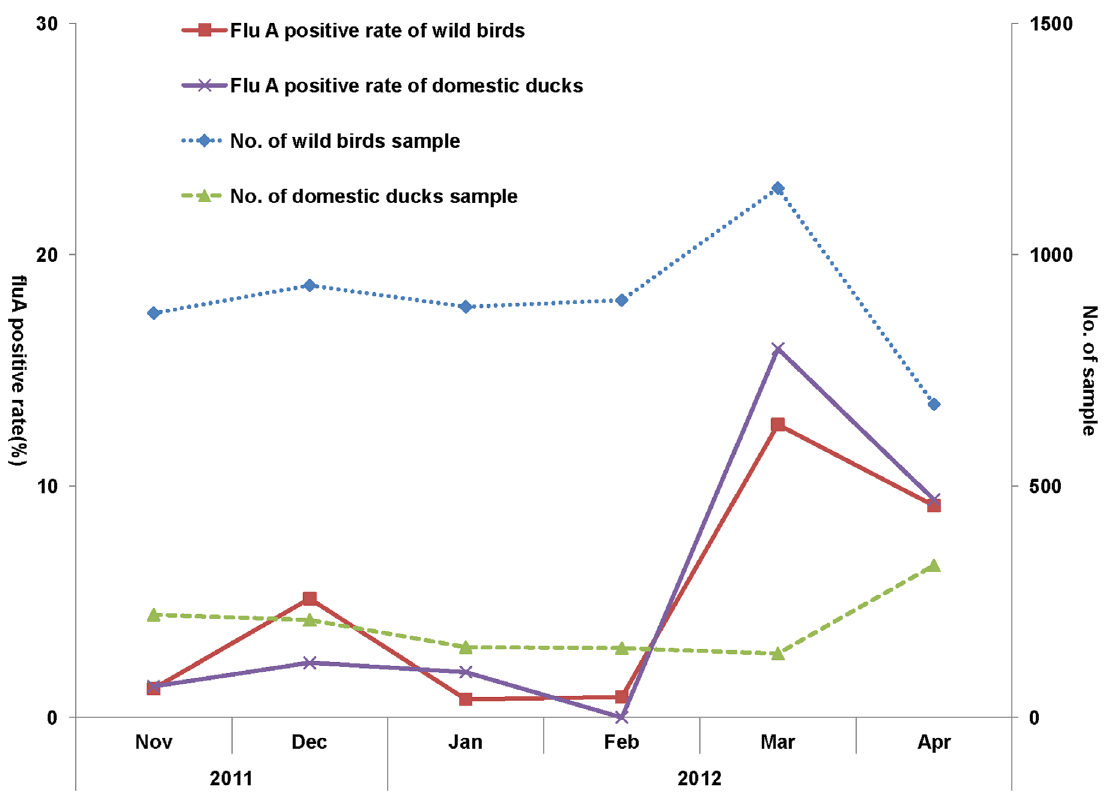
Figure 2. Time distribution of AIV prevalence in wild birds and domestic ducks.